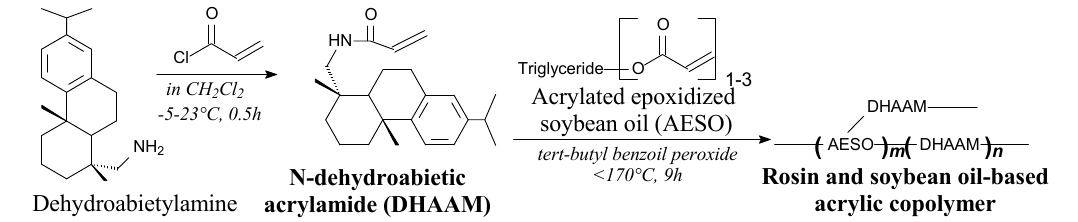
Scheme 62. Preparation of rosin and plant oil-based acrylic